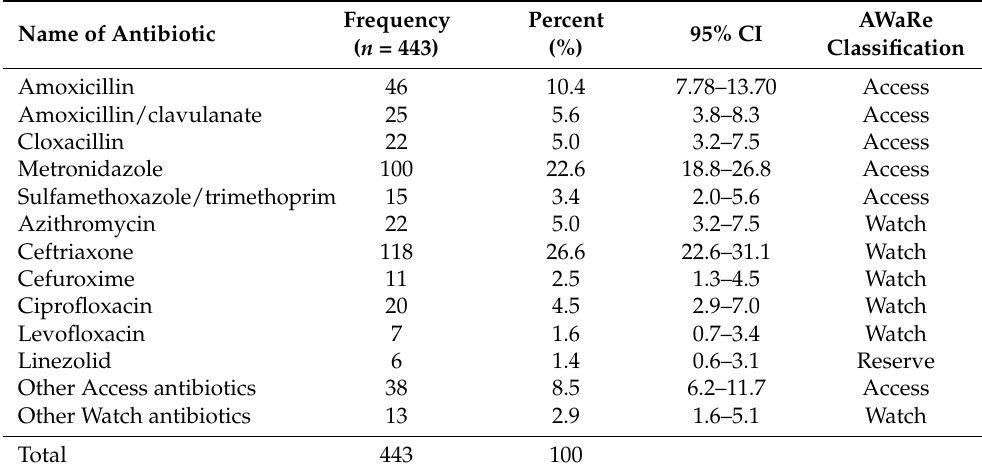
Table 2. Commonly prescribed antibiotics at the University Teaching